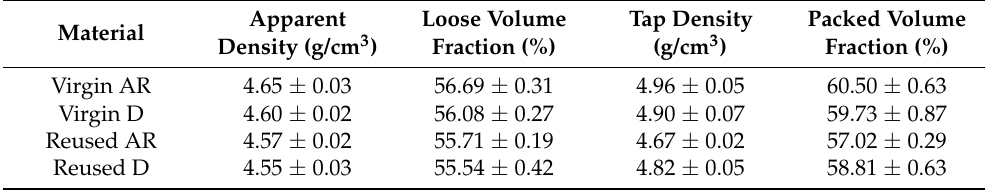
Table 3. Apparent density, tap density measured by the RPA and relative density calculated using Equation